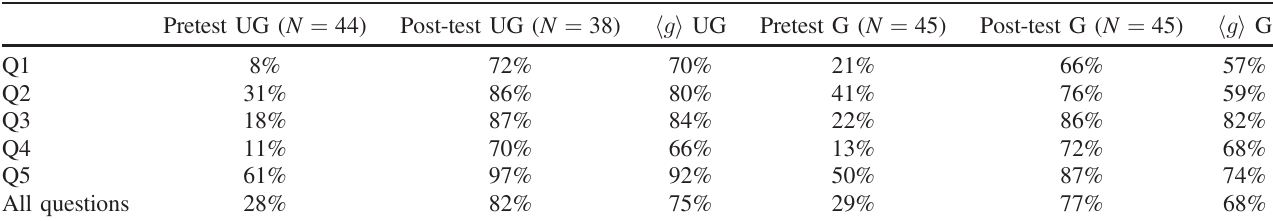
TABLE II. Average percentage scores and normalized gain h g i on the MZI pretest or post-test for undergraduate students (UG) and graduate students (G). The number of students who took the pretest does not match the post-test because some students did not work through the QuILT completely and their answers on the post-test were